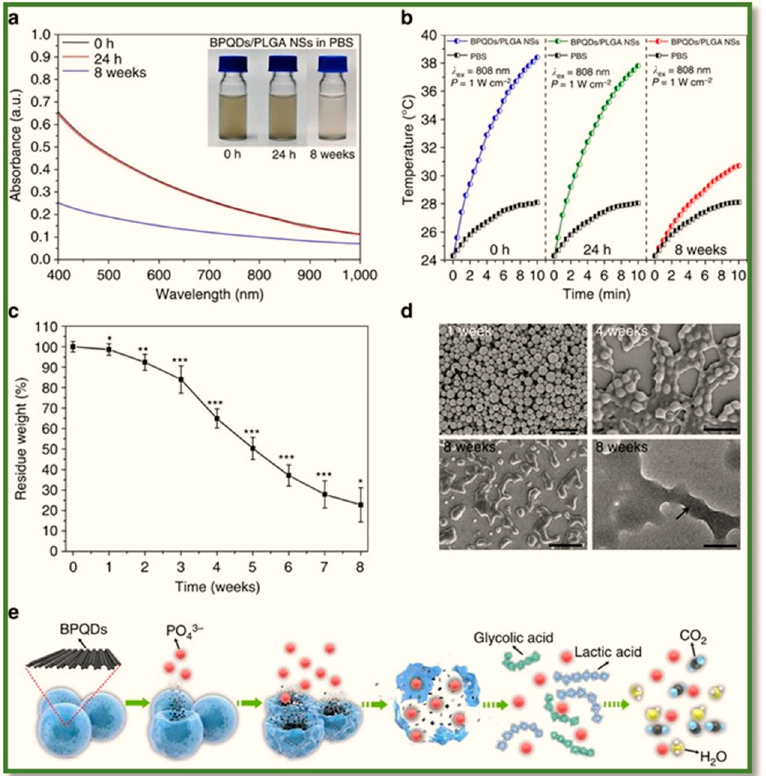
Figure 26. ( a ) Absorbance spectra of the BPQDs/PLGA NSs (internal BPQDs concentration is 10 p.p.m.) dispersed in PBS for 0 h, 24 h, and 8 weeks with the inset showing the corresponding pho- tographs. ( b ) Photothermal heating curves of the BPQDs/PLGA NSs dispersed in PBS for 0 h, 24 h, and 8 weeks and irradiated with the 808 nm laser (1 W cm − 2 ) for 10 min. ( c ) Residual weight of the BPQDs/PLGA NSs after degradation in PBS as a function of time ( n = 5; * p < 0.05, ** p < 0.01, *** p < 0.001; ANOVA). ( d ) SEM images (scale bars, 500 nm) of the BPQDs/PLGA NSs after degradation in PBS for 1, 4, and 8 weeks together with the corresponding TEM image (scale bar, 200 nm) of the NSs after degradation for 8 weeks. ( e ) Schematic representation of the degradation process of the BPQDs/PLGA NSs in the physiological environment. Copyright 2016, open access article distributed under the terms of the Creative Commons CC BY license, which permits unrestricted use, distribu- tion, and reproduction in any medium, provided the original work is properly cited, J. Shao, H. Xie,